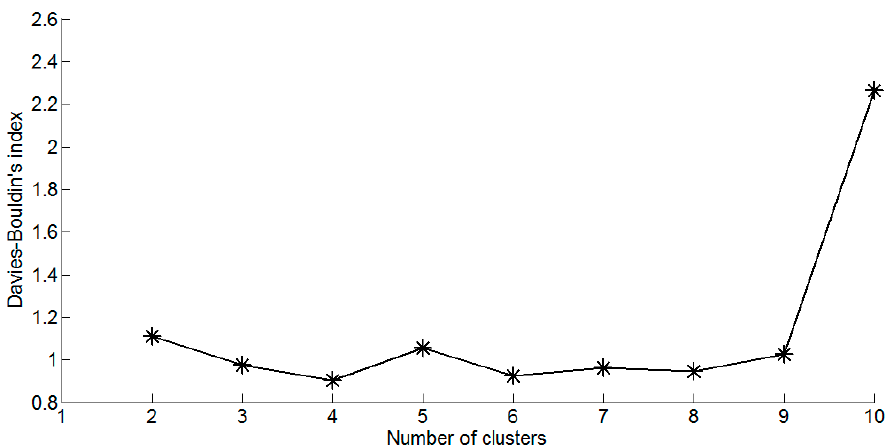
Figure 4. Davies-Bouldin clustering index of the K-means clustering algorithm.